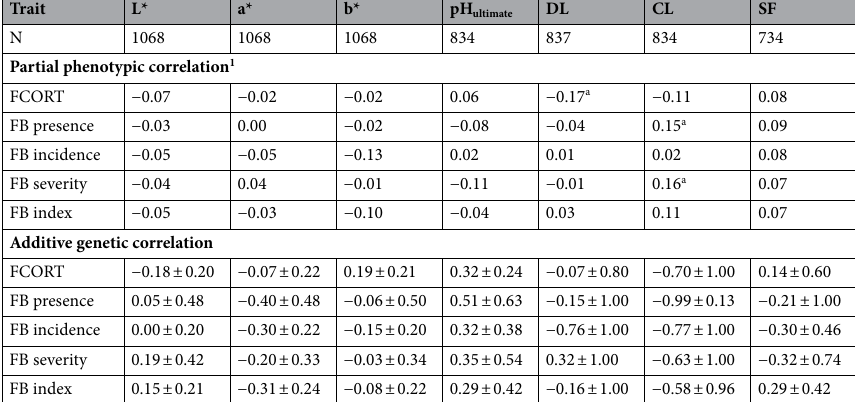
Table 4. Genetic and partial phenotypic correlations of feather corticosterone (FCORT) and fault bar (FB) traits with meat quality traits in turkeys (N = 734–1068 depending on trait). Meat quality traits include lightness (L*), redness (a*), yellowness (b*), pH ultimate , drip loss (DL, %), cooking loss (CL, %), and shear force (SF, N). 1 Significant partial phenotypic correlations are denoted by letter superscripts where a = p < 0.05 and b = p <